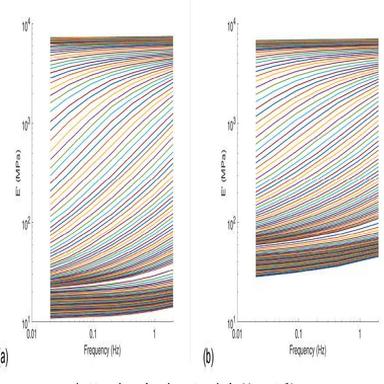
Isotherms from the DMA results for (a) F-NR4, (b) F-NR5.